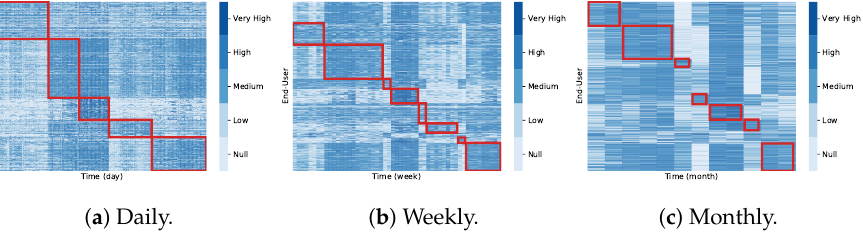
Figure 18. Rearranged daily, weekly, and monthly consumption data matrices to reveal the coclus- tering solutions ( N = 5, N = 10, N = 10) at InfraQuinta, 2017. Each of the identified coclusters are highlighted in red. Note that for the weekly and monthly datasets, we only highlight the valid coclusters, as the algorithm did not find coclusters for all the users.